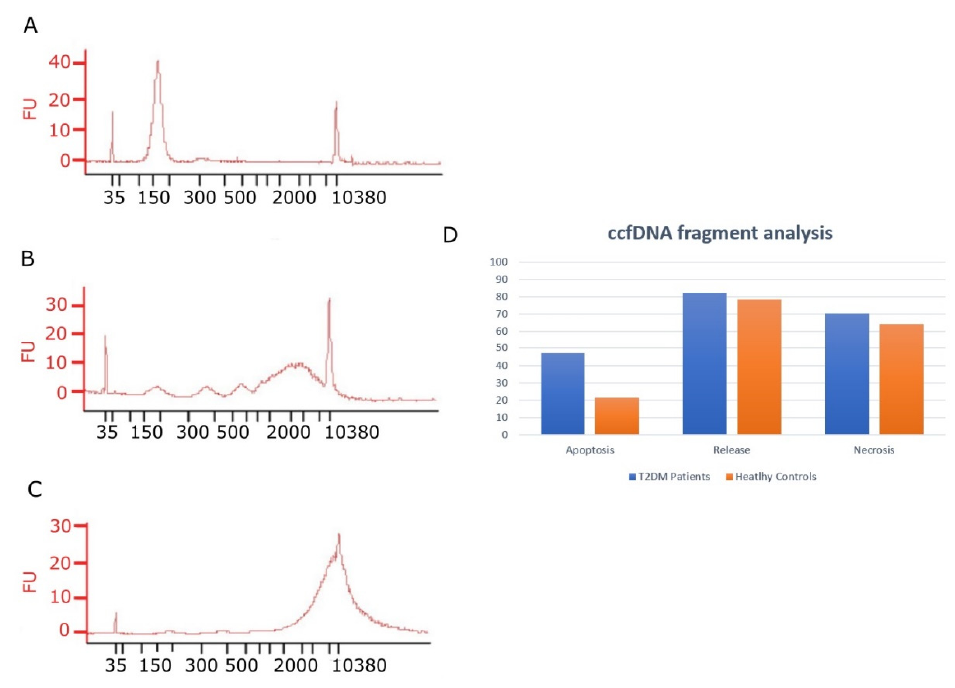
Figure 3. Representative capillary electropherograms showing DNA fragment size distribution in ccfDNA isolated from sera of two T2DM patients and one healthy control. ( A ) A T2DM patient ccfDNA sample showing a peak at ~160 bp indicative of apoptosis. ( B ) Another T2DM patient ccfDNA sample showing multiple peaks at ~160 bp, ~300 bp and ~500 bp indicative of apoptosis and an additional wide peak at ~2000–3000 bp indicative of active release. ( C ). A healthy volunteer ccfDNA sample with a wide peak at ~2000–3000 bp indicative of active release. Peaks at 35 bp and 10,380 bp in all electropherograms represent high and low ladders, respectively. ( D ) Distribution of ccfDNA fragment analysis in the patient’s group and the healthy volunteer’s group, respectively.